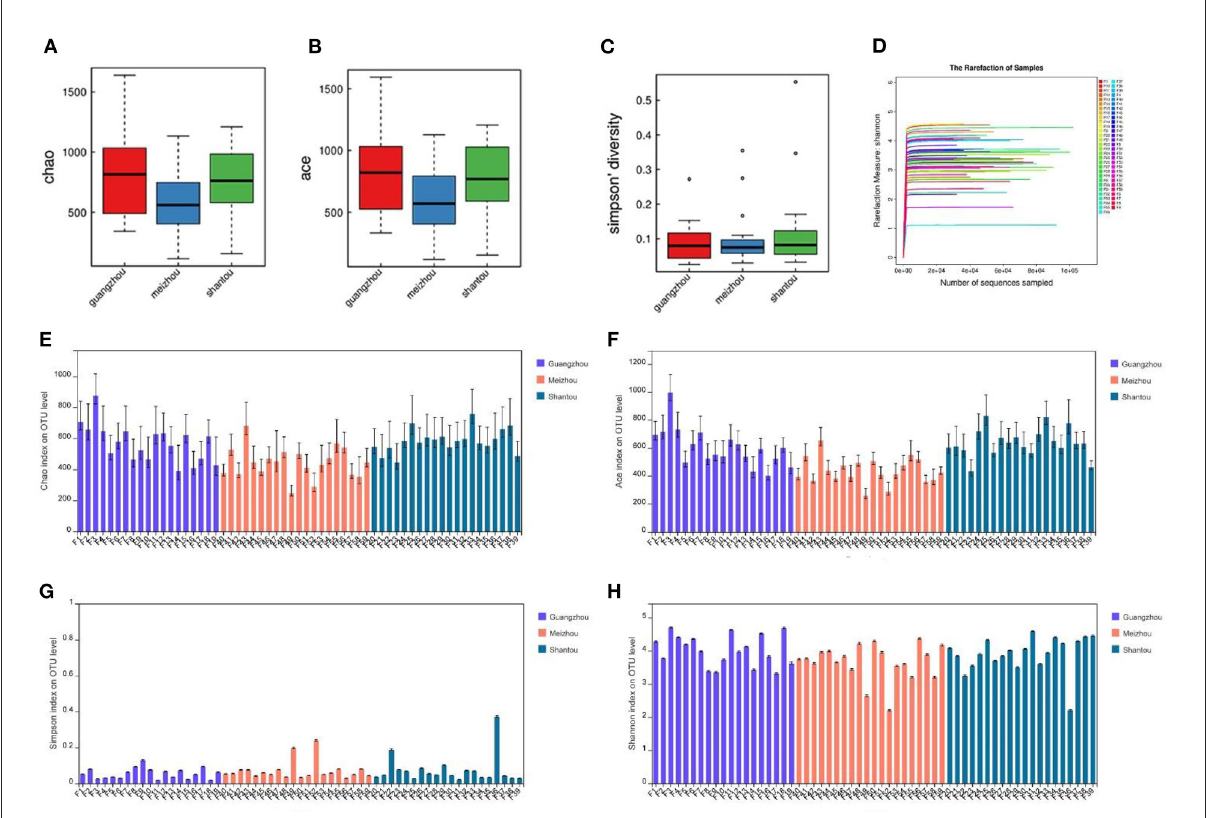
FIGURE2 Differences in bacterial alpha diversity among the three regions: (A,E) Chao. (B,F) Ace. (C,G) Simpson diversity. (D,H) Shannon index.